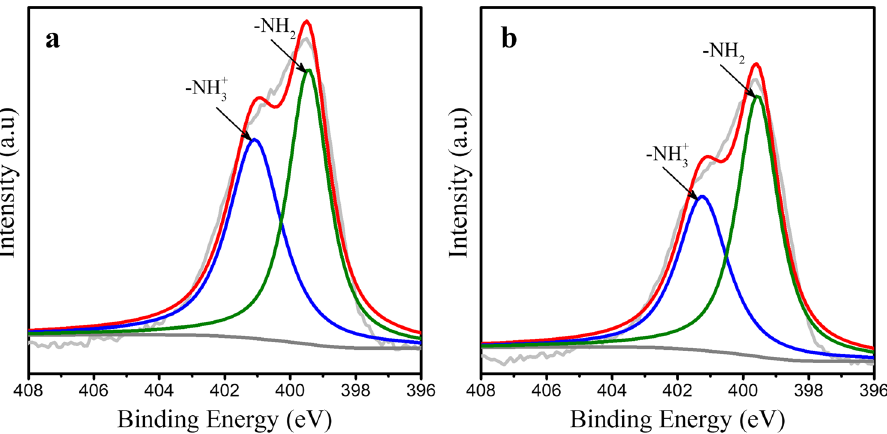
Figure 3. The N 1s spectra of amine functionalized mesoporous silica showing –NH 2 and –NH 3+ peaks ( a ) before adsorption ( b ) after adsorption. Decrease in –NH 3+ peak was observed after